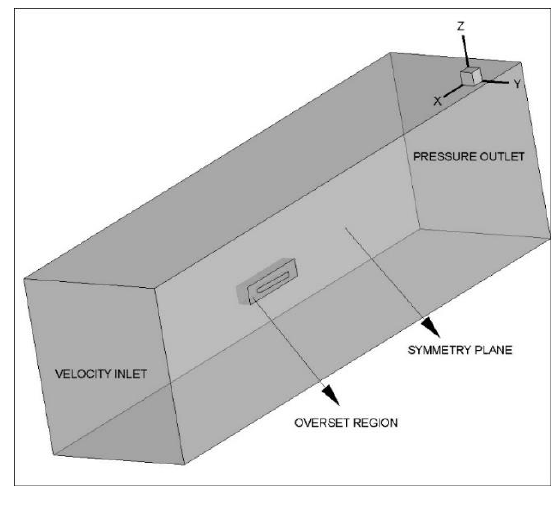
Figure 4. Boundary conditions. Figure 4. Boundary